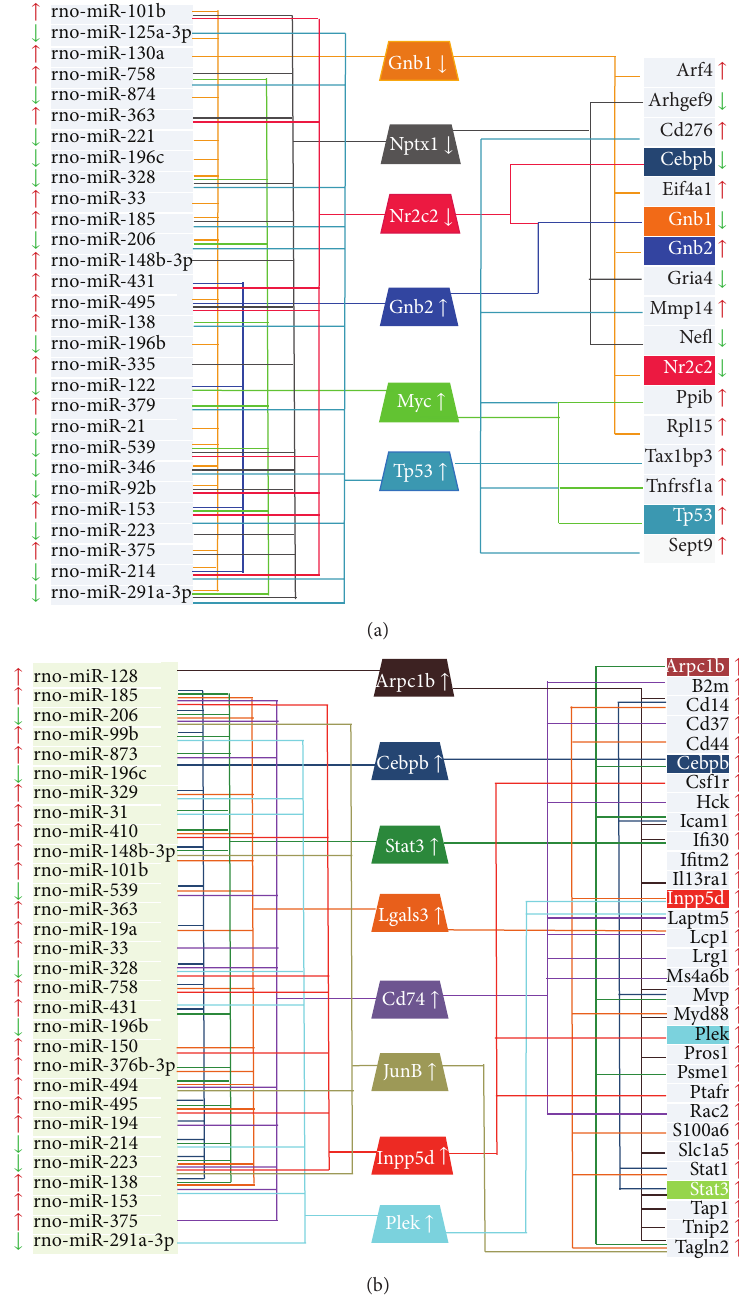
Figure 2: Regulatory subnetworks for two time points following transient retinal ischemia-reperfusion injury. The networks contain three types of molecules: miRNAs (shown in the left column), TFs (shown as trapezoids in the center), and coding gene targets (shown in the right column). All of these molecules changed their expression in response to IR injury twofold or more, relative to their sham controls. The arrows next to each gene correspond to gene regulation: uppointed arrows indicate increased gene expression; downpointed arrows indicate decreased gene expression. TFs, miRNAs, and coding genes that are linked with the same colored line indicate that the miRNAs target the TFs and at the same time, both of these regulators cotarget the coding genes. With the notable exception of Cebpb, there were no common target coding genes or TFs in the 2 subnetworks, even though they shared 19 common miRNAs. (a) Regulatory subnetwork consisting of miRNAs, TFs, and target genes, which changed their expression at the 24 h IR injury time point relative to their sham controls (FC ≥ 2). At this post-IR time point, six TFs were fine-tuned by 29 miRNAs to jointly regulate 17 target genes. (b) Regulatory subnetwork consisting of miRNAs, TFs, and target genes, which changed their expression at 7 days after IR injury relative to their sham controls (FC ≥ 2). At this post-IR time point, eight TFs were regulated by 30 miRNAs to jointly control the expression of 31 target